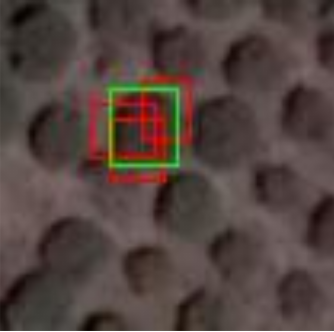
Figure 8. An example of non-maximal suppression (NMS). The rectangles represent a detected tree, and the green rectangle indicates the biggest classification